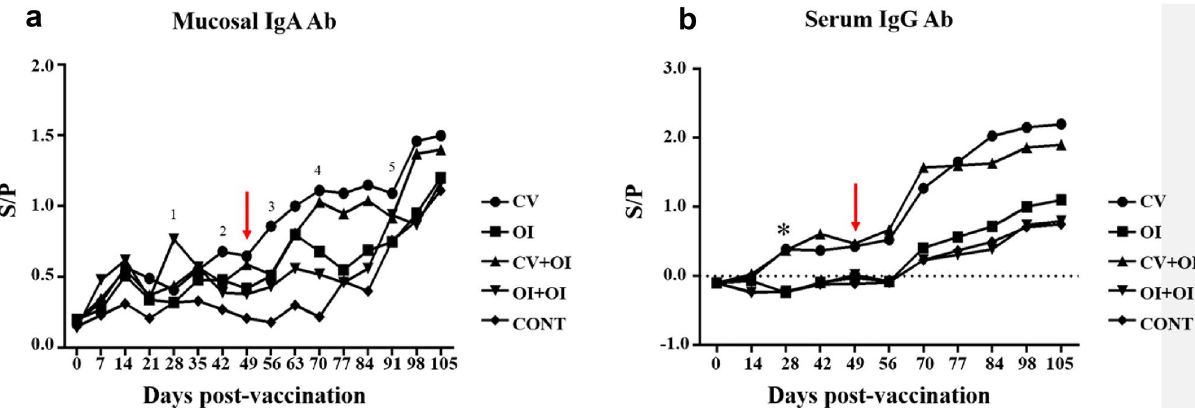
Figure 3. ( a ) Mucosal IgA antibody response related to different immunization protocols (D0) against M. hyopneumoniae along the experimental period. Dots represent the mean values of each group in each day of sampling. Positive S/P values > 0.4. ( b ) Serum IgG antibody response obtained in different immunization protocols (D0) against M. hyopneumoniae along experimental period. Piglets challenged with M. hyopneumoniae on D49 (red arrows). Dots represent the mean values of each group in each day of sampling. Positive S/P values > 0.3. Kruskall-Wallis test was used.